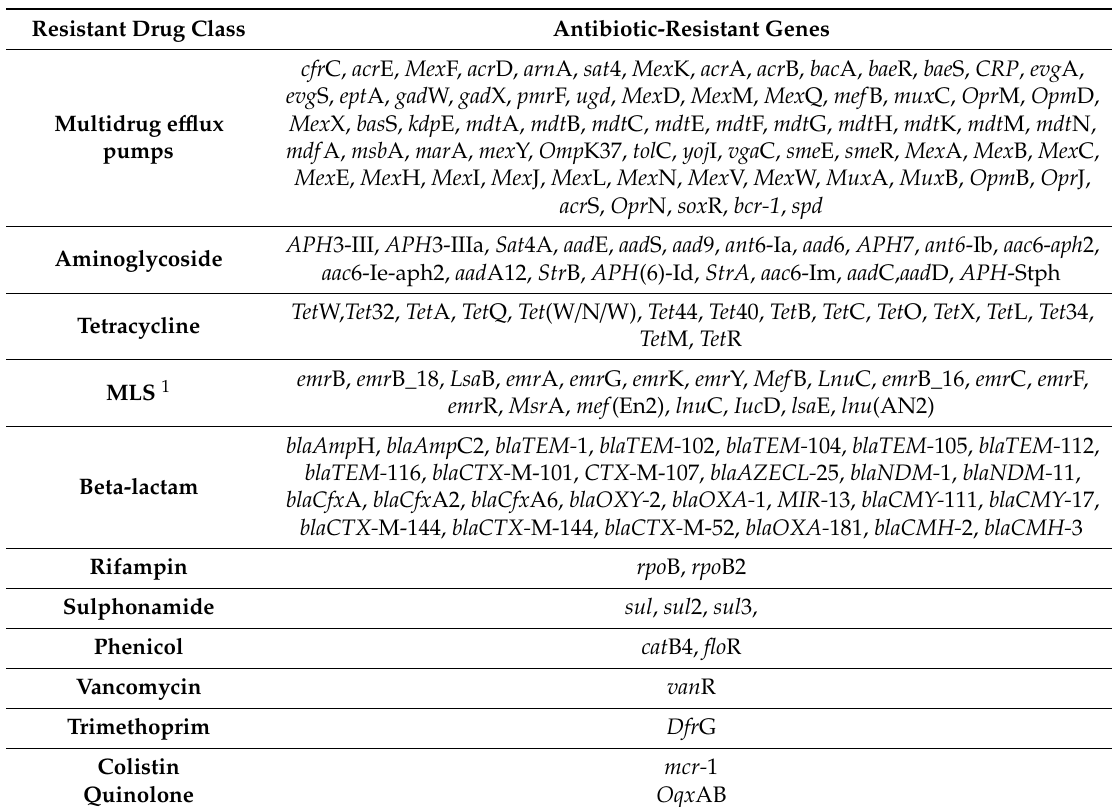
Table 1. Types of antibiotics genes identified using next-generation sequencing in the resistome of multidrug-resistant E. coli infected